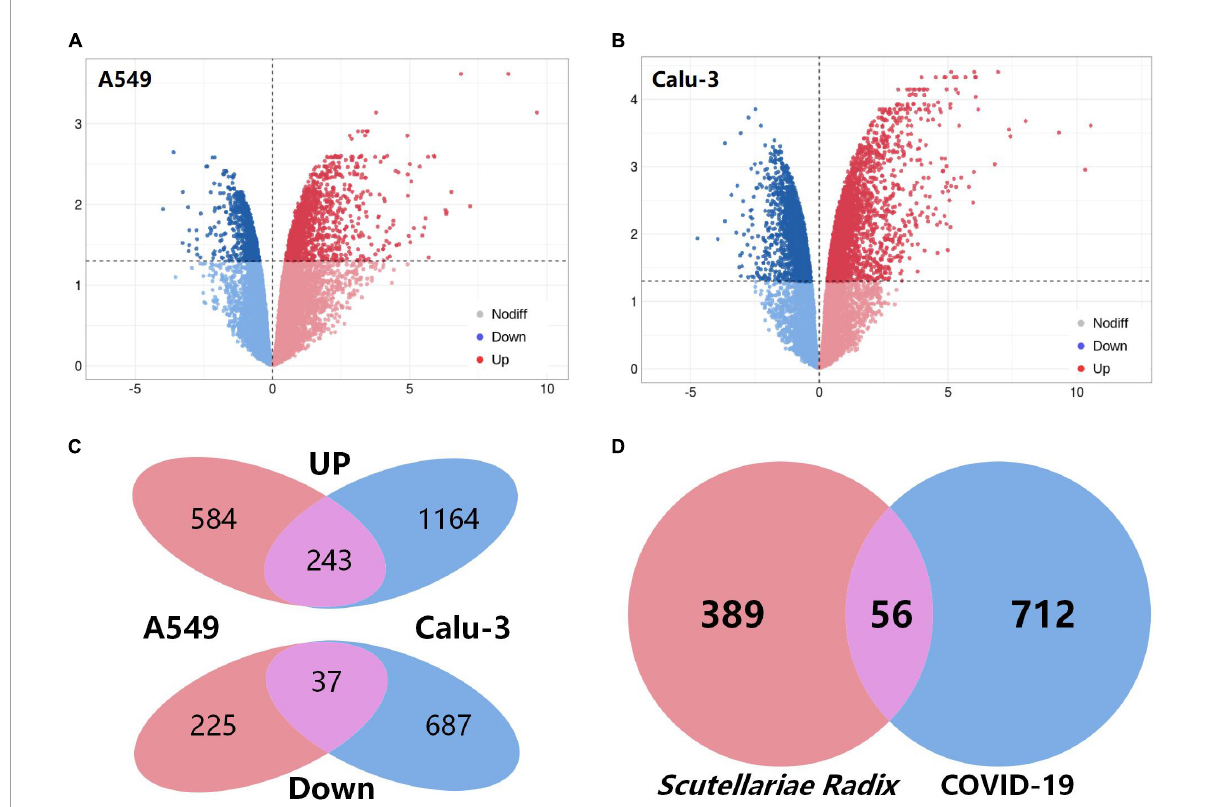
FIGURE3 Acquisition of COVID-19-related targets and intersection targets. (A,B) Volcano plot of differentially expressed genes (comparison before and after SARS-CoV-2 infection) of A549 and calu-3 cell lines in GSE147507. Red: up-regulated; blue: down-regulated. (C) Venn diagram of common differential genes in A549 and calu-3 cell lines. (D) Venn diagram of potential targets of Scutellariae radix for the treatment of